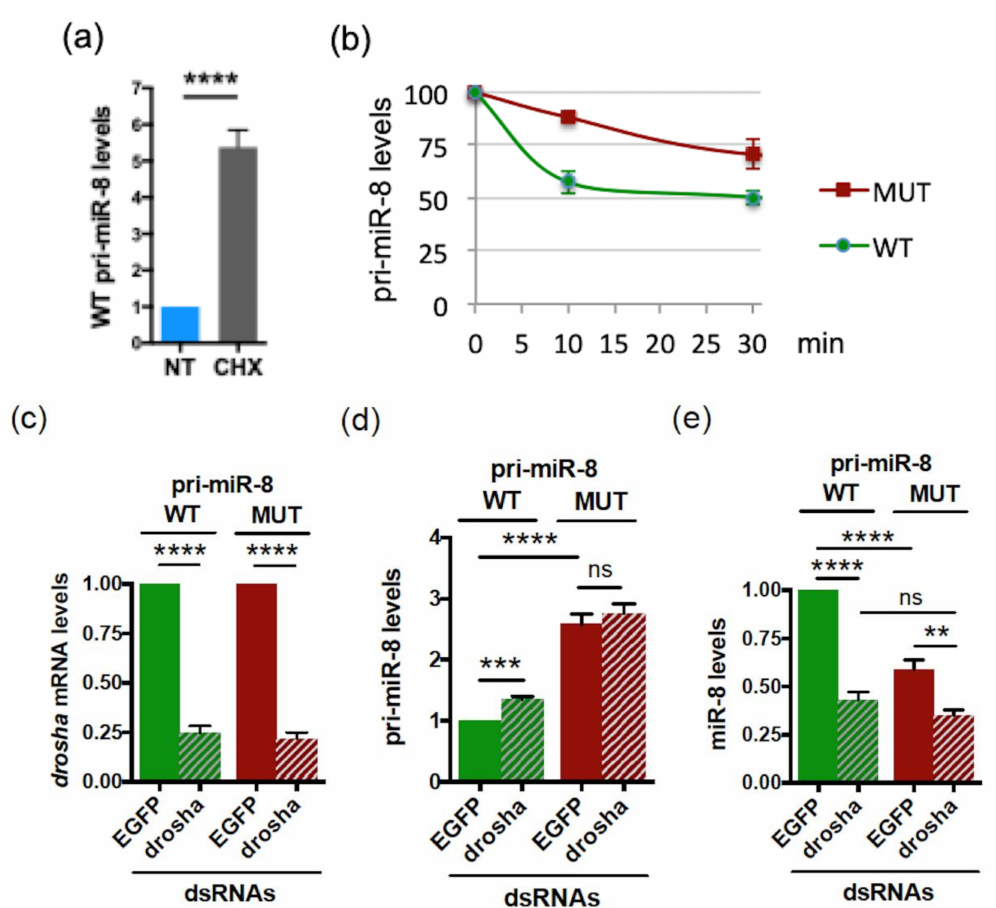
Figure 6. The mutant pri-miR-8 is more stable and insensitive to Drosha depletion. ( a ) Relative expression levels of WT pri-miR-8 transfected into S2 cells upon CHX treatment (30 µ g/mL for 4 h). WT pri-miR-8 levels, determined by qRT-PCR, were normalized to GAL4 and set to 1 for the untreated (NT) transfected cells. Data are means ± S.E.M. n = 7. ( b ) Relative expression levels of WT or MUT pri-miR-8 transfected in S2 cells, upon Actinomycin D treatment (1 mg/mL) for various times. Pri-miR-8 levels, determined by qRT-PCR, were normalized to RP49 and set to 100 for the untreated transfected cells. Data are representative of two independent experiments performed in triplicate. ( c , d , e ) Relative expression levels of Drosha mRNA ( c ) or pri-miR-8 ( d ) or miR-8 ( e ) in S2 cells first transfected with dsRNA EGFP or dsRNA drosha and then transfected with WT or MUT pri-miR-8 constructs. ( c ) The drosha mRNA levels, determined by qRT-PCR, were normalized to tubulin and set to 1 for EGFP dsRNA transfected cells. ( d , e ) the pri-miR-8 levels ( d ) and miR-8 levels ( e ) determined by qRT-PCR, were normalized to GAL4 for pri-miR-8 ( d ) and U14 for miR-8 ( e ) and set to 1 for EGFP dsRNA WT pri-miR-8 transfected cells. Data are means ± S.E.M. n = 8. ** p < 0.01, *** p < 0.001, **** p < 0.0001, ns: not